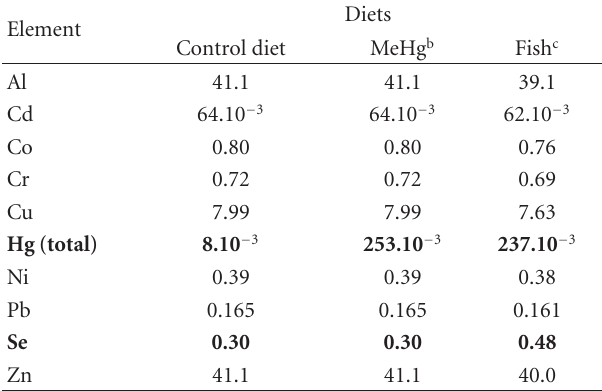
Table 2: The metal and selenium composition of the diets used a . Element